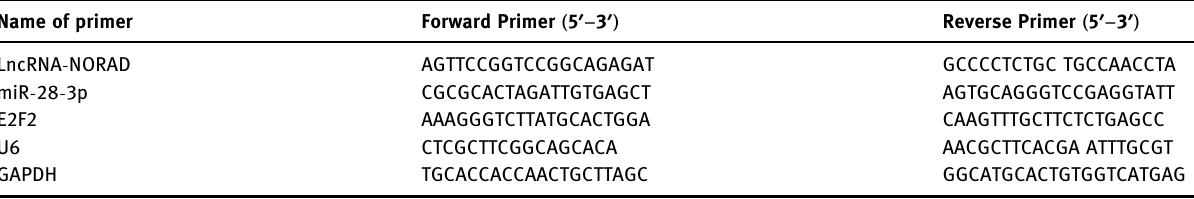
Table 1: Primer sequence of RT - qPCR Name of